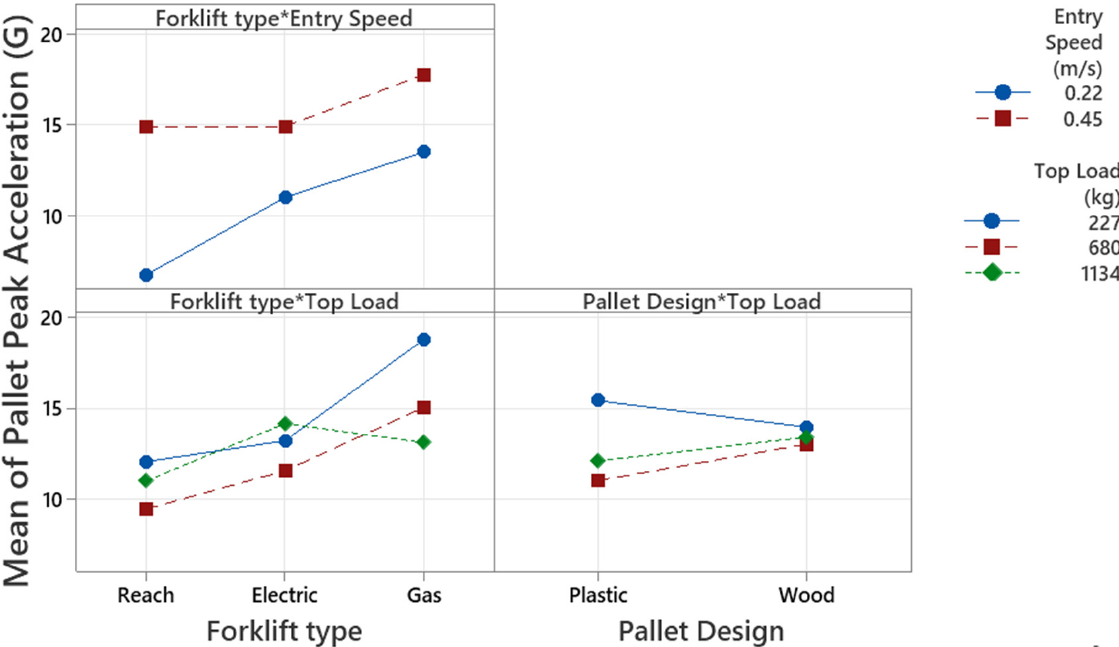
Figure 7. Interaction plot for pallet peak acceleration